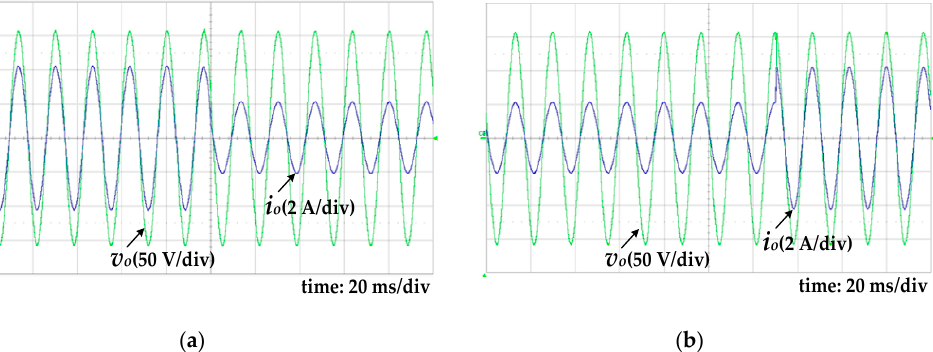
Figure 10. Measured waveforms of output voltage v o and output current i o when the inverter is operated with a step-load change of ( a ) from 320 W to 160 W; ( b ) from 160 W to 320 W.